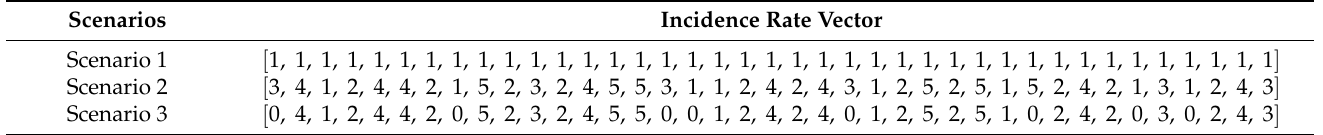
Table 2. Incidence rate vectors for Case Study #1.